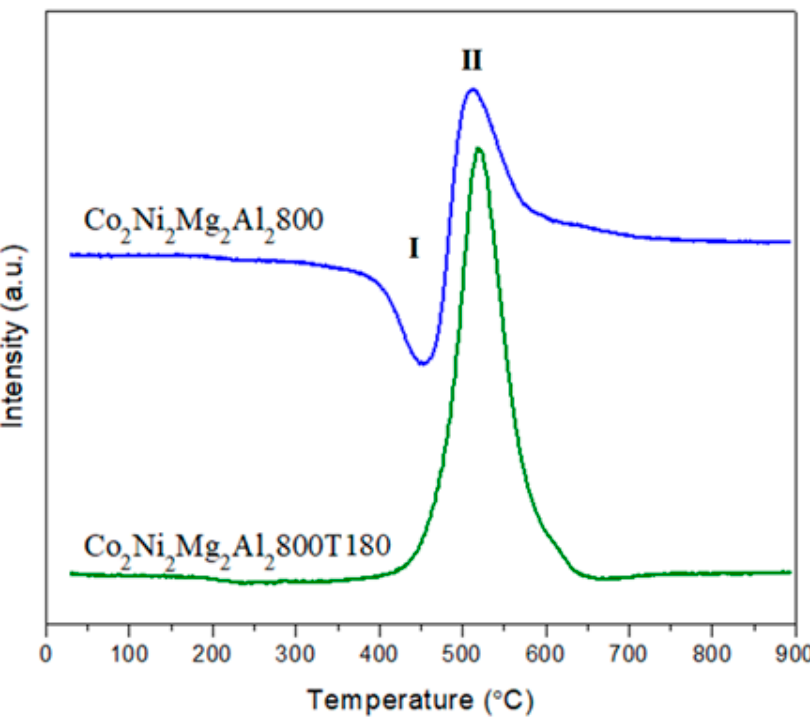
Figure 15. Temperature programmed oxidation (TPO) profiles of Co 2 Ni 2 Mg 2 Al 2 800 after the dry reforming of methane in the absence and in the presence of 180 ppm of toluene.